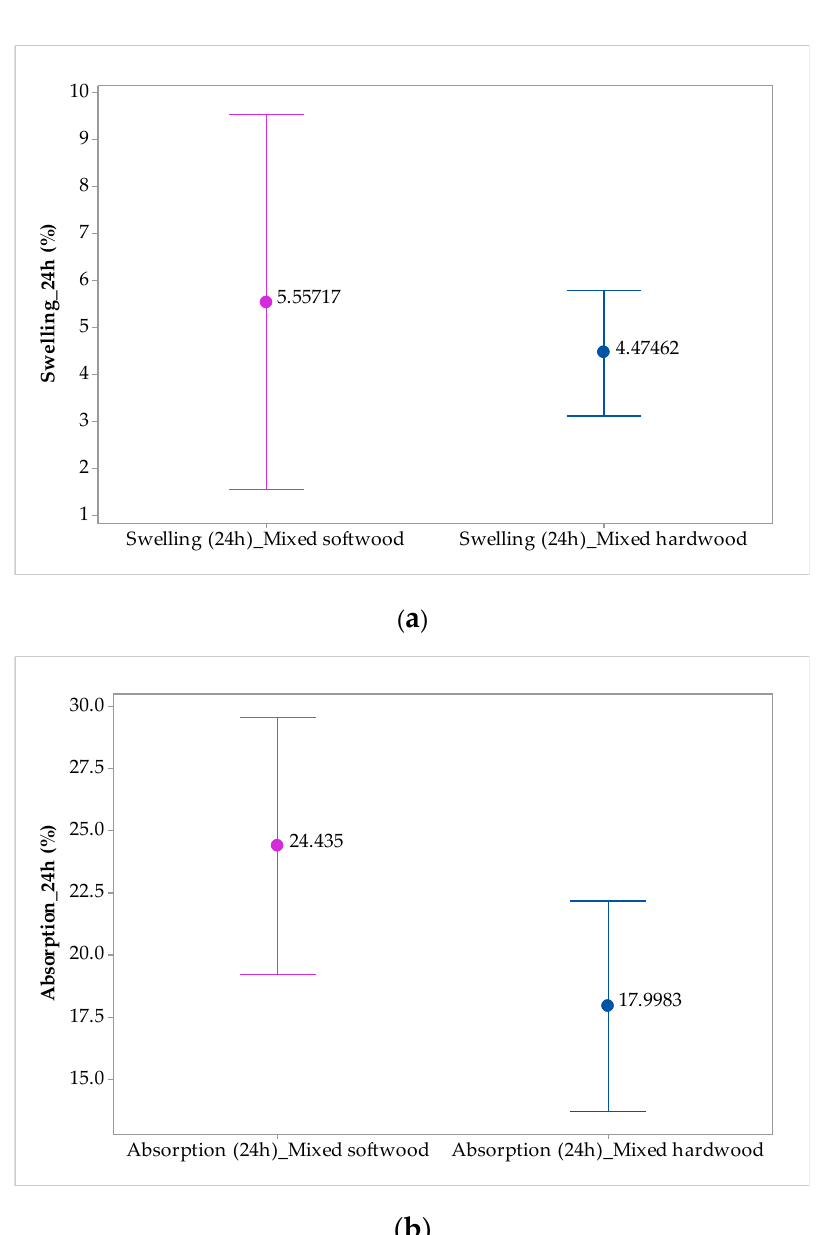
Figure 3. Interval plot of analyzed properties for OSB types: ( a ) swelling; ( b ) absorption.